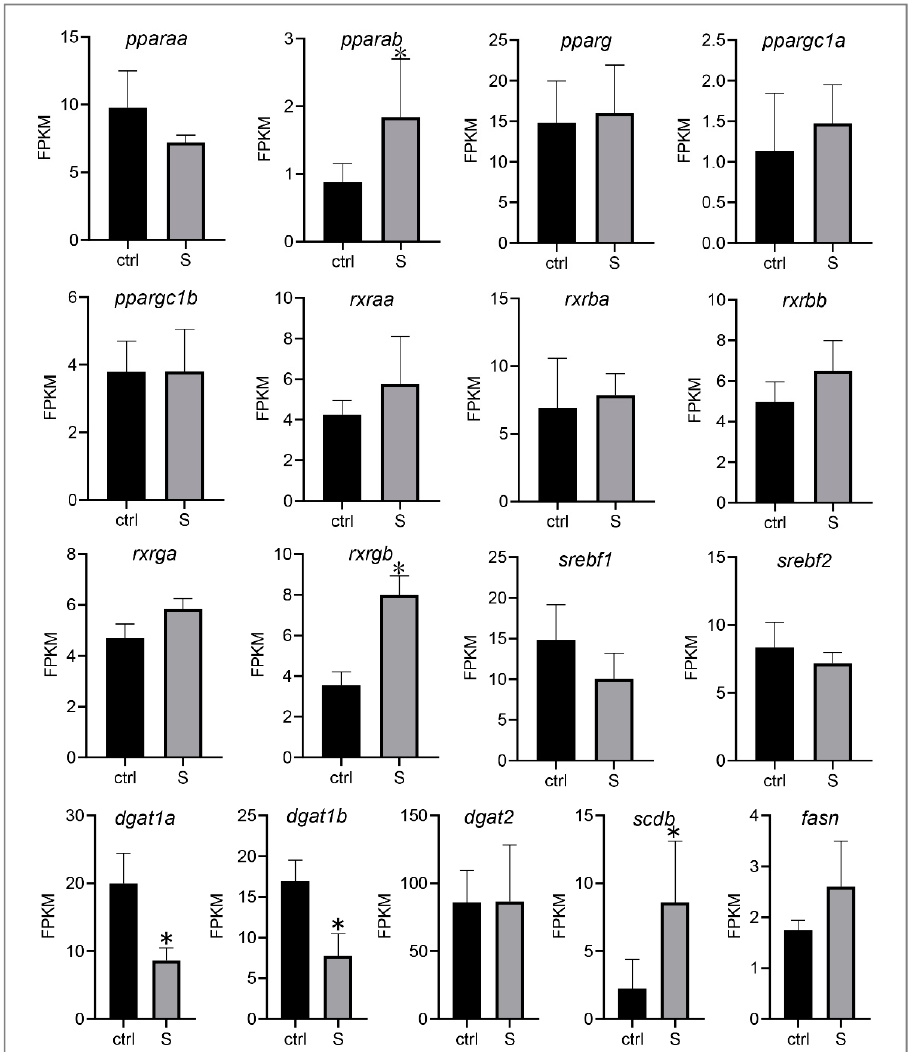
Figure 6. Effect of starvation on the gene expression involved in lipogenesis in liver tissues. Differential expression of pparaa , pparab , pparg , ppargc1a , ppargc1b , srebf1 , srebf2 , dgat1a , dagt1b , dgat2 , scdb , fasn , rxraa , rxrba , rxrbb , rxrga , and rxrgb in the control and starved larvae. The FPKM value represents the mean ± SEM of three independent RNA-seq biological replicates. * indicates significant differences ( p < 0.05).